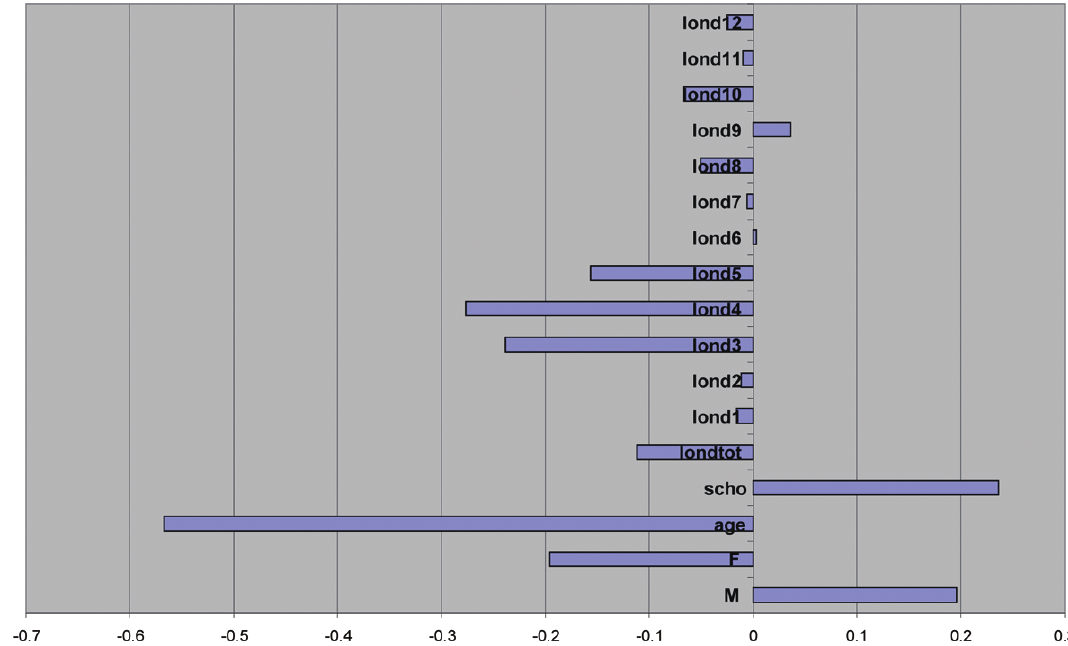
Fig. 1. Each bar represent the value of the correlation index R between the specific items of Tower of London test(lond 1; lond 2; etc.) total score of Tower of London test(lond tot) male and female gender, age, schooling years (scho) and presence of FTD. Negative value of R denote variables whose value is inversely correlated with the presence of FTD while positive value of R denote variables whose value is positively correlated with FTD presence.